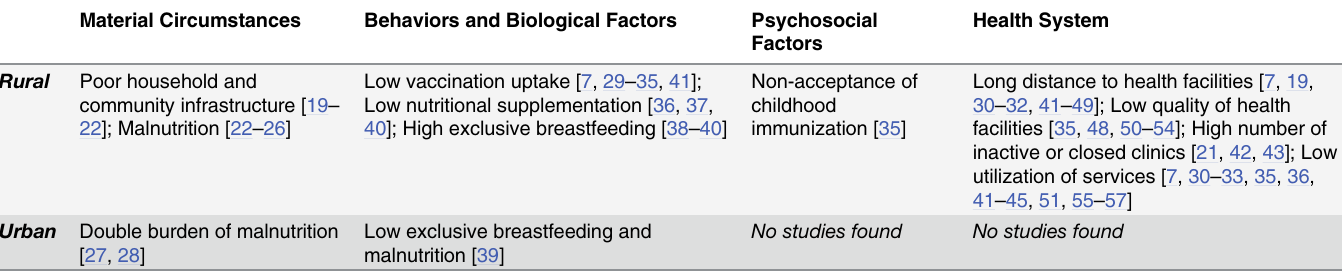
Table 1. Place of Residence and Child Health in